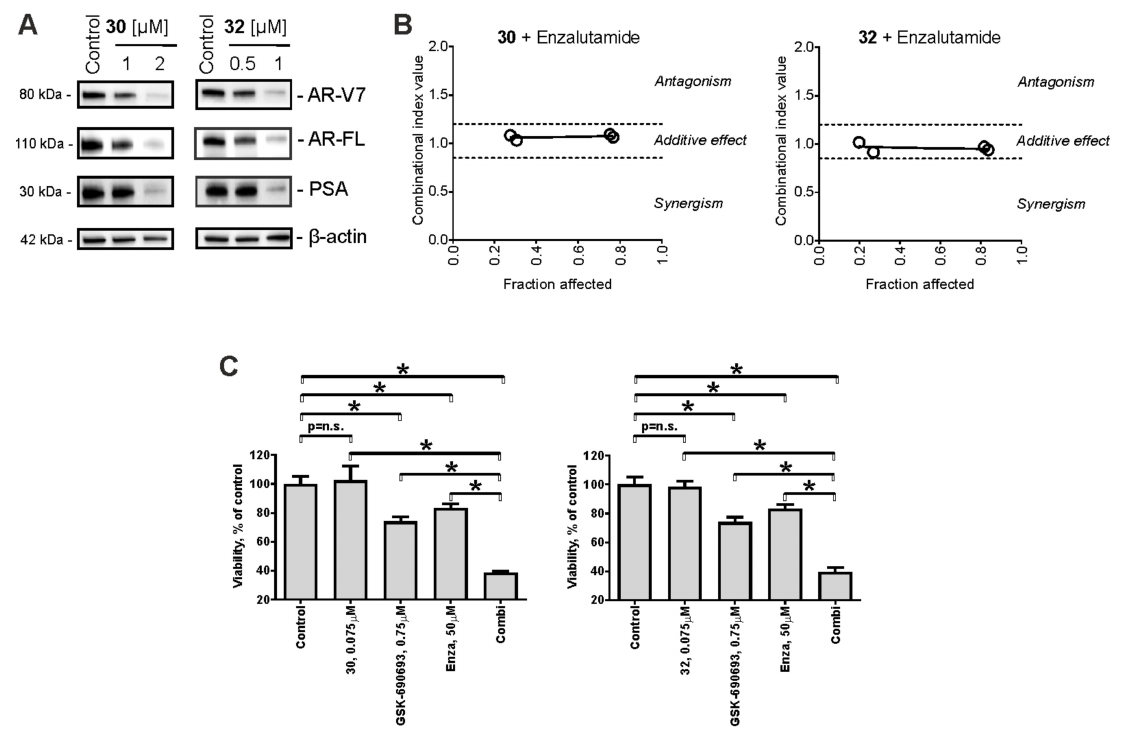
Figure 5. Analysis of the effect on AR signaling. ( A ) Effects of 30 and 32 on the expression of different proteins involved in AR signaling. Cells were treated for 48 h and the protein expression was accessed using Western blotting. β -Actin was